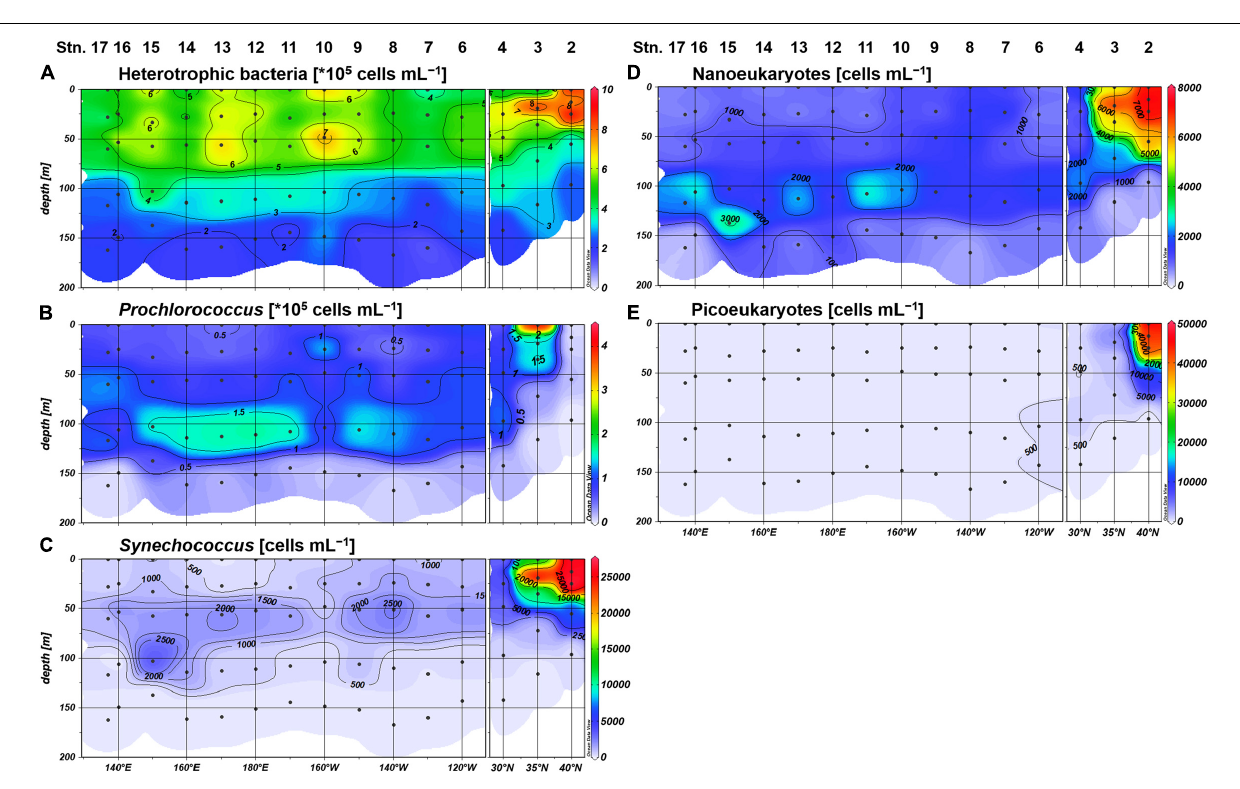
The vertical profiles of monoester concentrations also demonstrated longitudinal variability. Monoester concentrations were high around the sea surface and decreased with depth in the eastern half of the transect (Stations 4–12) ( Figure 4 ).